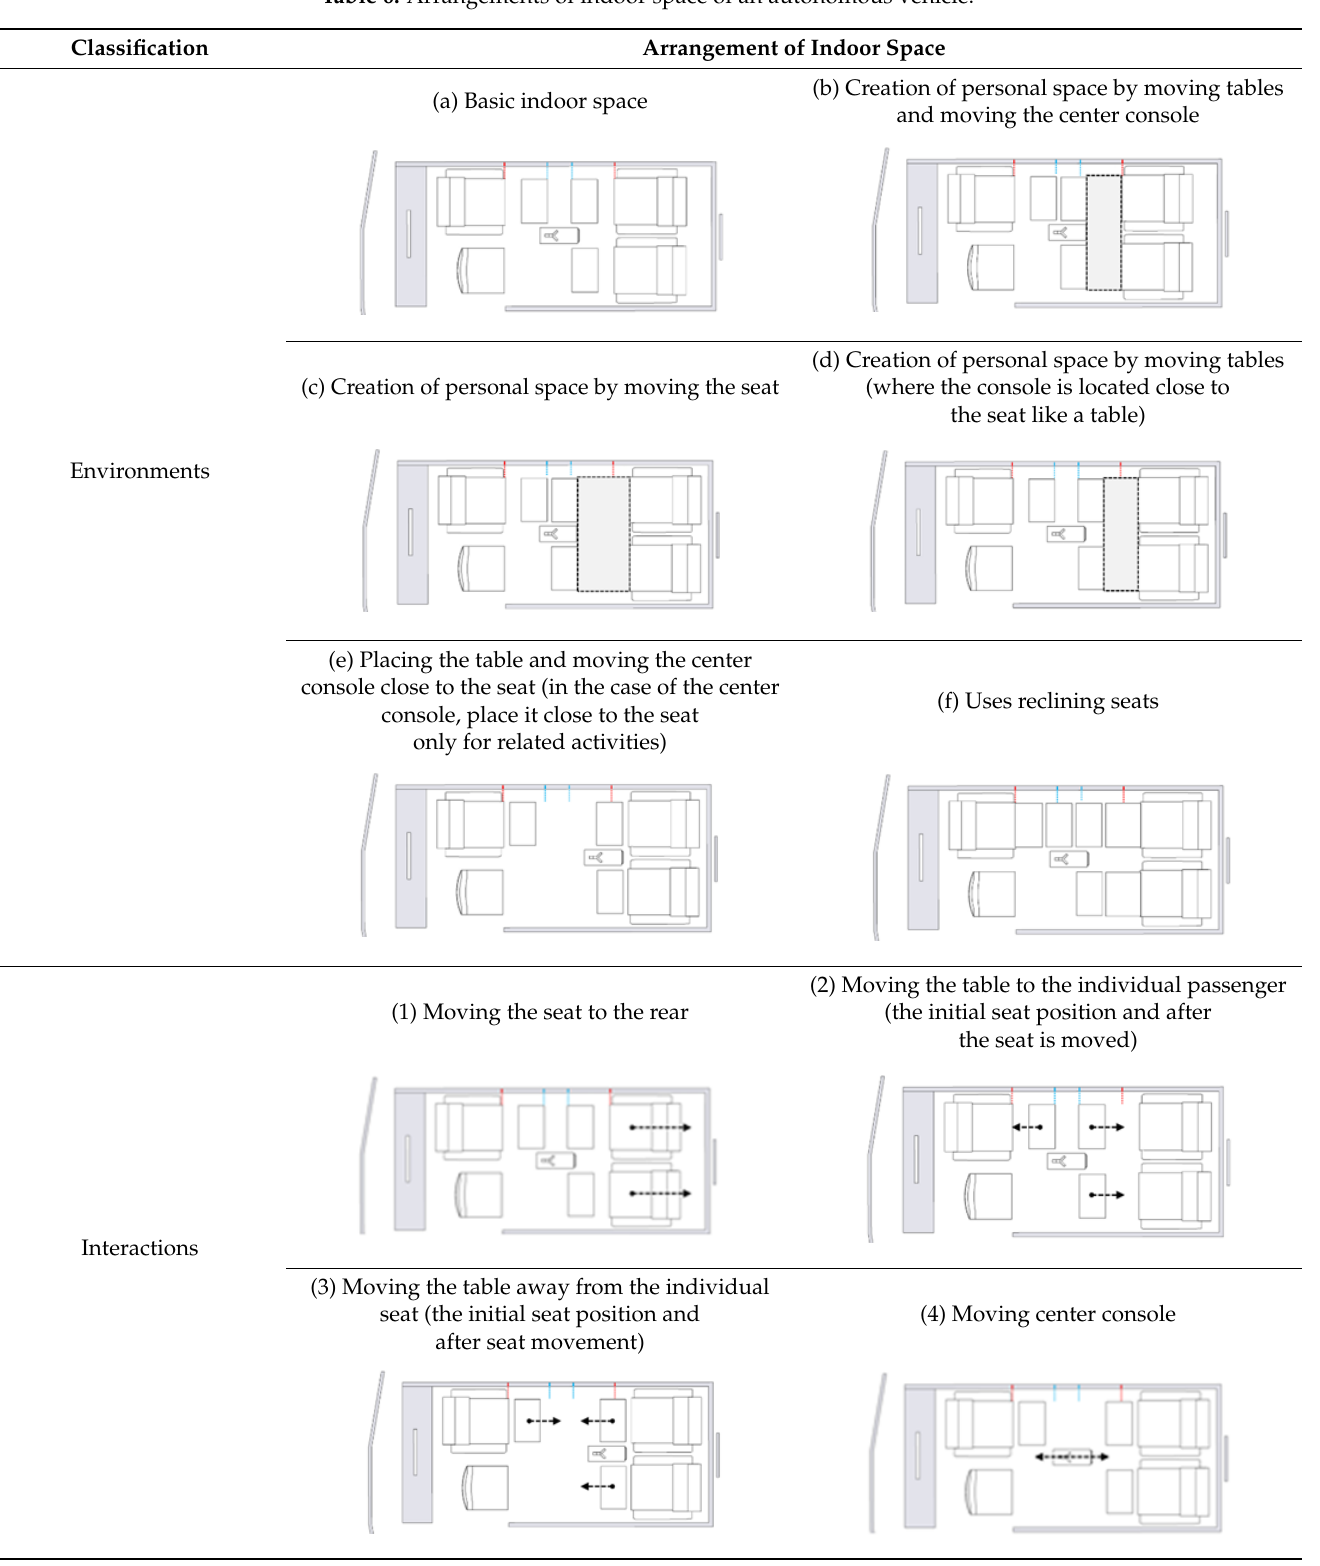
Table 6. Arrangements of indoor space of an autonomous vehicle.